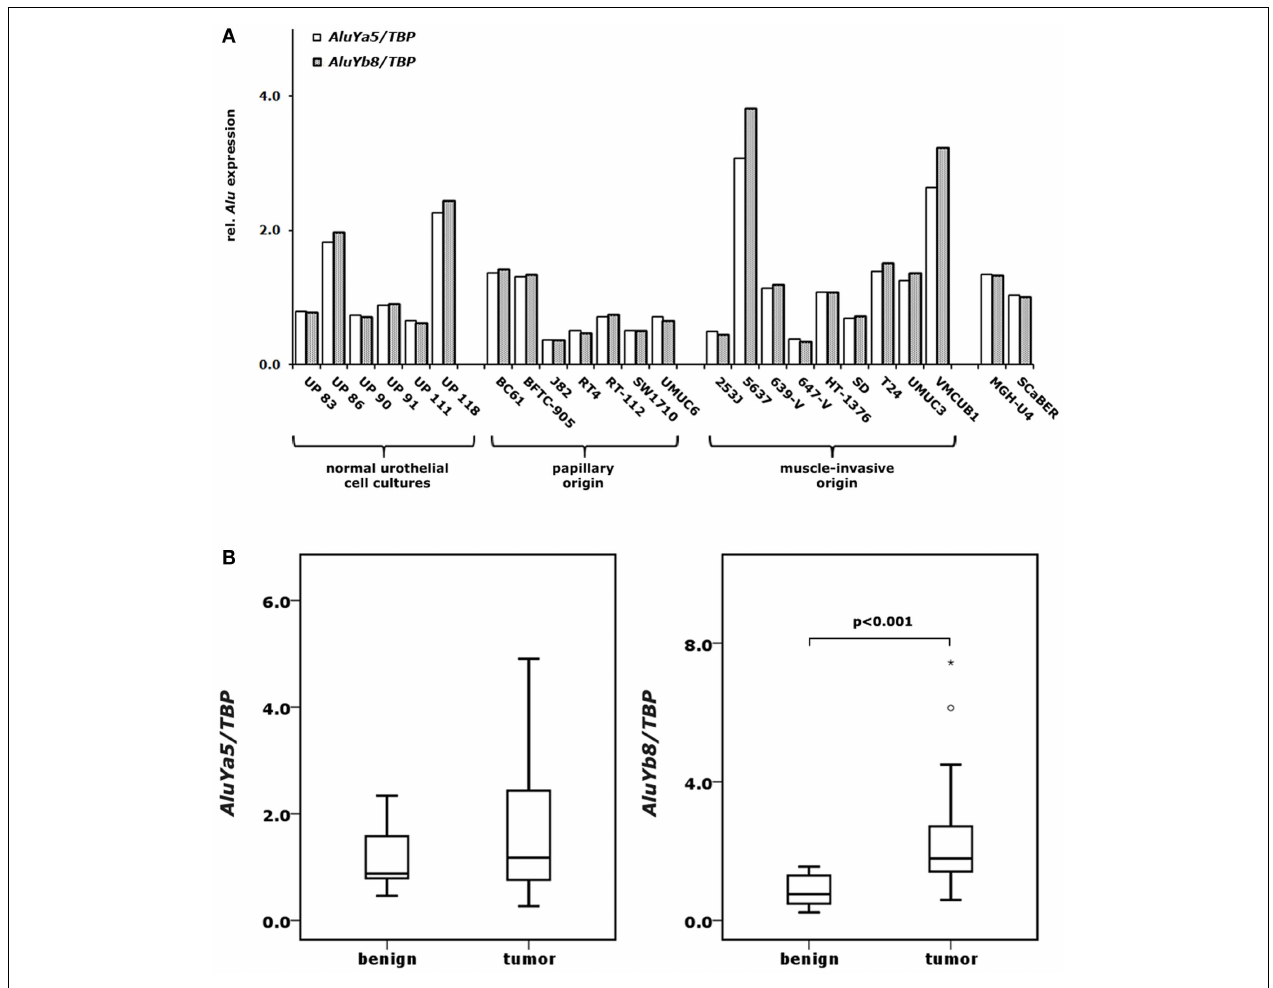
normal urothelial cell cultures (A) or the median RNA level of benign bladder tissues (B) set as 1. p Values calculated by the Mann–Whitney U -test were given above the brackets for significant changes ( p < 0.05). Missing p values demonstrate changes without reaching the level of